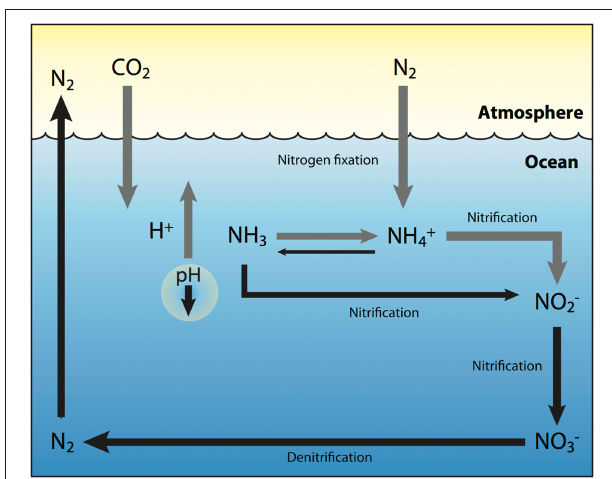
FIGURE 4 | Changes to the marine nitrogen cycle under future ocean acidification conditions. As additional CO 2 is absorbed by the ocean and reacts with water molecules (H 2 O), carbonic acid is formed and broken down into both bicarbonate (H 2 CO 3 ) and hydrogen (H + ) ions (gray arrow), which reduces bioavailable carbonate and decreases ocean pH (black arrow). This is likely to enhance nitrogen fixation by diazatrophs (gray arrow), which utilize H + ions to convert N 2 into bioavailable forms such as ammonia (NH 3 ) and ammonium ions (NH + 4 ). However, as pH decreases, and more ammonia molecules are converted to ammonium ions (gray arrow), there is less oxidation of ammonia to nitrite (NO − 2 ), resulting in an overall decrease in nitrification and denitrification (black arrows). This in turn would lead to a further build up of fixed nitrogen in the ocean, with the potential consequence of eutrophication. Gray arrows represent an increase while black arrows represent a decrease in the associated